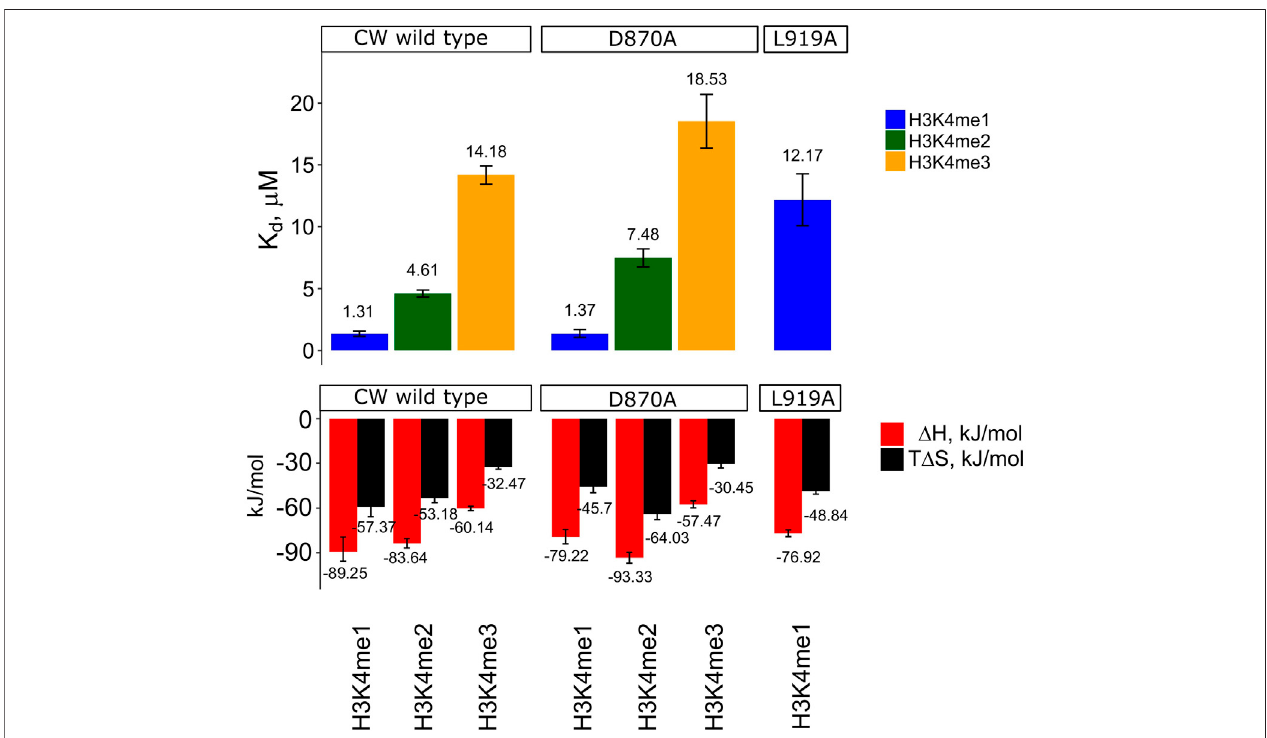
FIGURE 5 | K d , Δ H, and T Δ S values determined by ITC. Data shown only for WT CW and mutants D870A and L919A, as insC868-SFPN-C871 and I915A did not produceinterpretableisotherms.Enthalpyofbindingwasdeterminedbystepwisetitrationof400 – 1,800 μ Mhistonepeptideto50 – 180 μ MsampledissolvedinT7buffer (25 mM Tris-HCL pH 7.0, 150 mM NaCl, and 1 mM TCEP) at 25 ° C. For the comparison, the entropic component was multiplied by the temperature. The values can be foundin SupplementaryTableS3 .Errorbarsrepresentonestandarddeviation(n=3).AllpairwisecomparisonsbetweenK d valueswithintheCWwildtypegroup aresigni fi cant(student's t -test, p < 0.01).D870Avs.CWwildtype(me2/3),andL919Avs.CWwildtype(me1),aresigni fi cant(student's t -test, p < 0.05),whileD870Avs. CW wild type (me1) is not ( p = 0.416). Representative isotherms can be found in Supplementary Figures S2